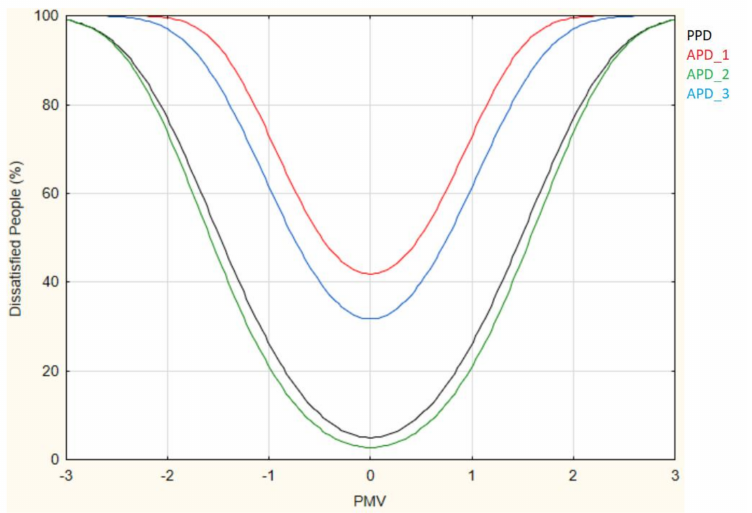
Figure 9. Comparison between APDs and